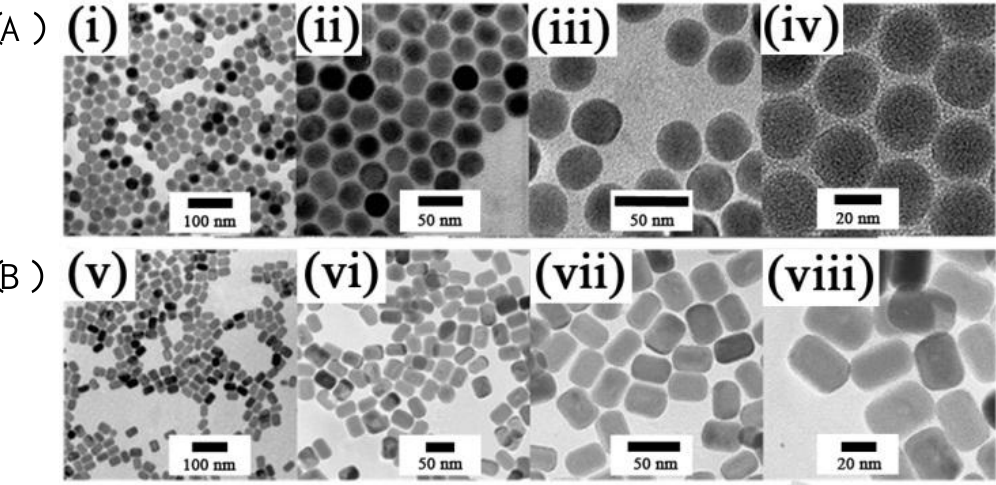
:Ce 3+ (Yb 3+ ) Ln nanorods (Ln:Tb, Eu, Dy, Sm, Er 4